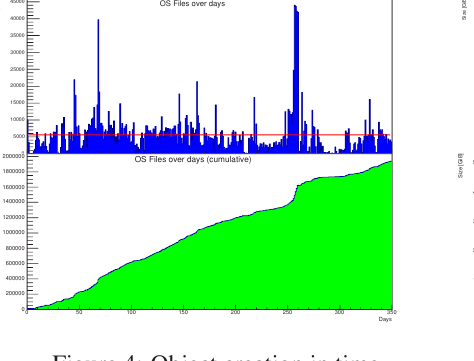
Figure 4: Object creation in time Figure 5: Object size in time